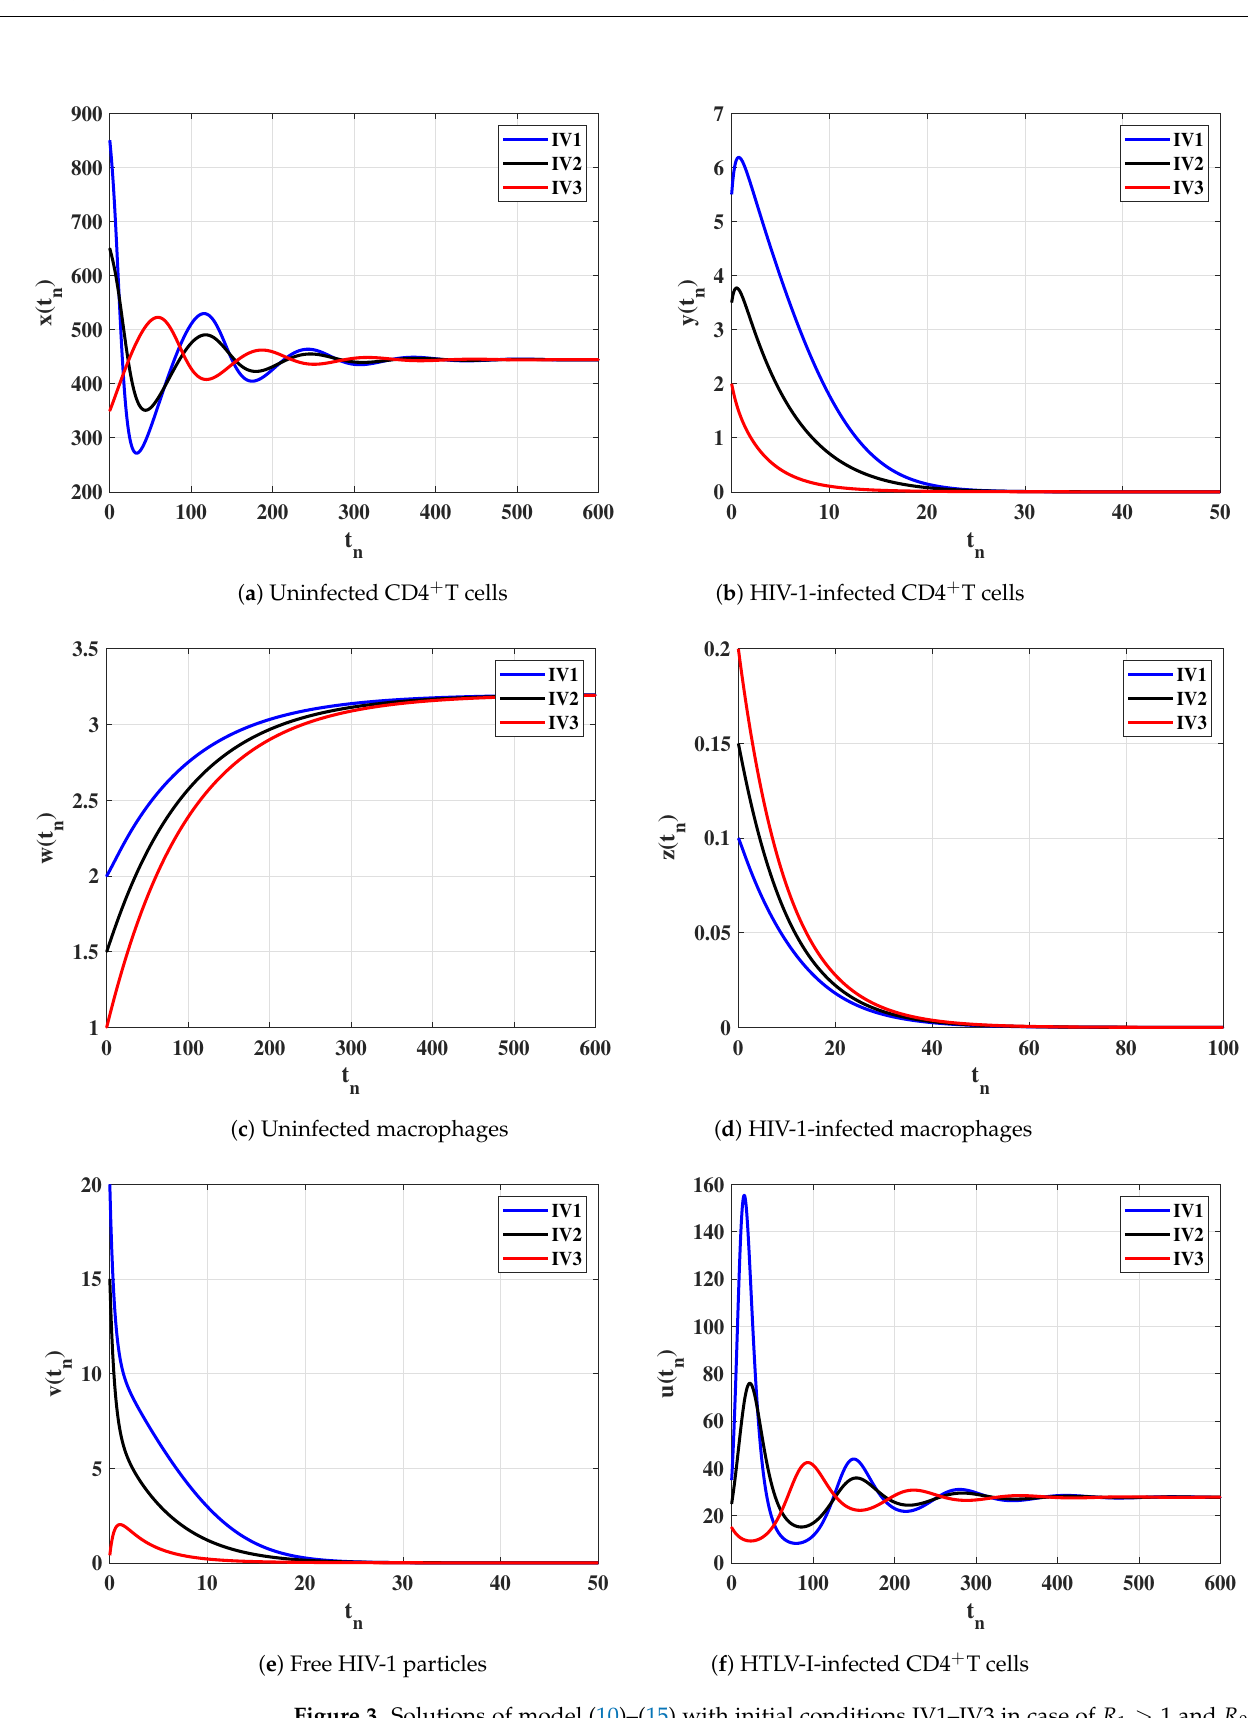
Figure 3. Solutions of model (10)–(15) with initial conditions IV1–IV3 in case of R 1 > 1 and R 02 + R 01 ≤ R 1